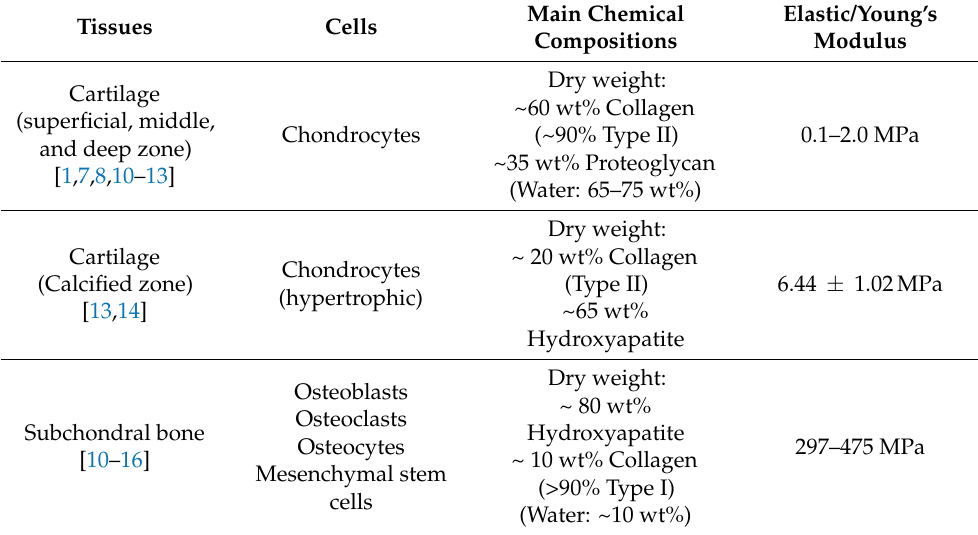
Main Chemical Compositions